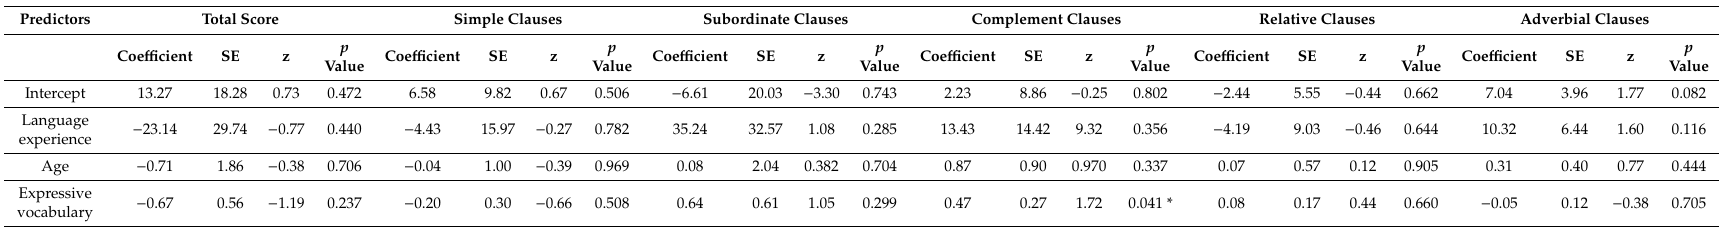
Table 4. Summary of logit mixed e ff ects models for grammaticality in sentence repetition: Total scores, simple vs. subordinate clauses, and clause-types. Predictors